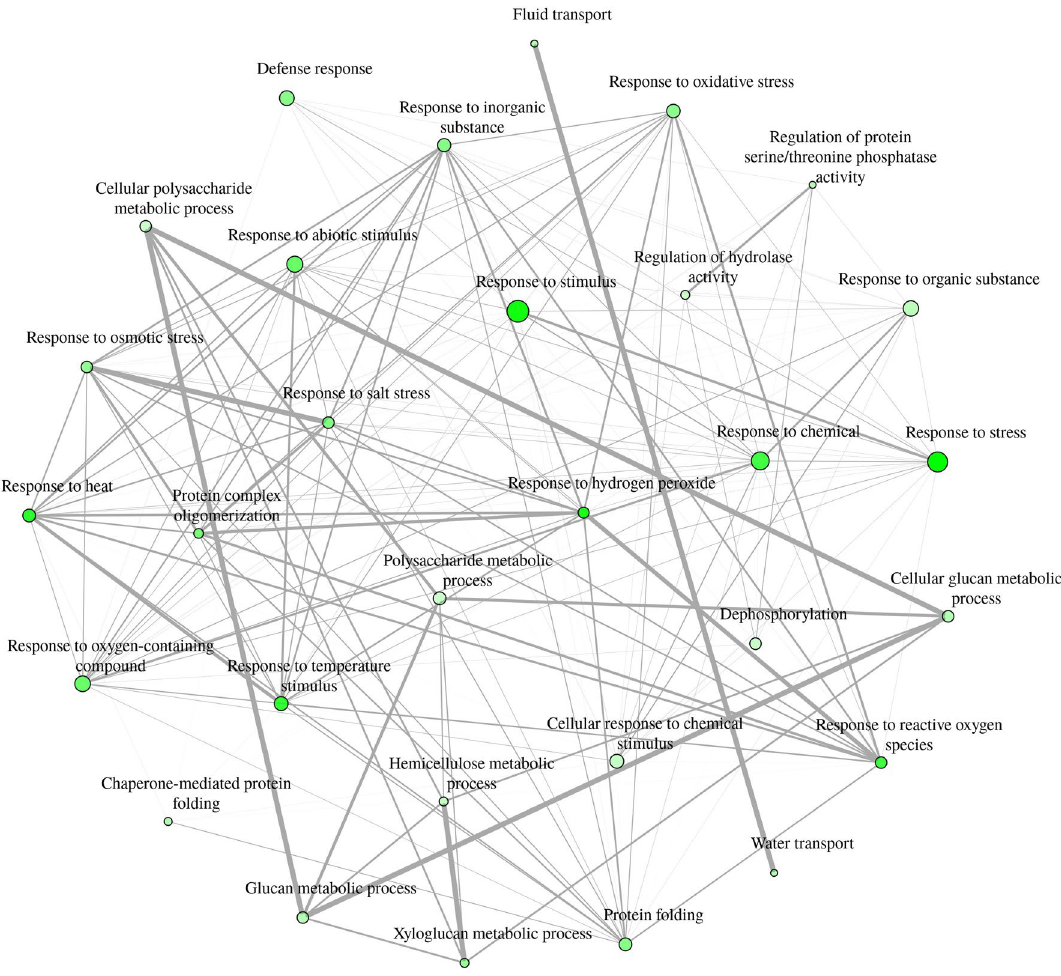
Figure 5. Interactive plot showing the relationship between enriched pathways. Two pathways (nodes) are connected if they share 20% or more genes. Darker nodes are more significantly enriched gene sets. Bigger nodes represent larger gene sets. Thicker edges represent more overlapped genes.